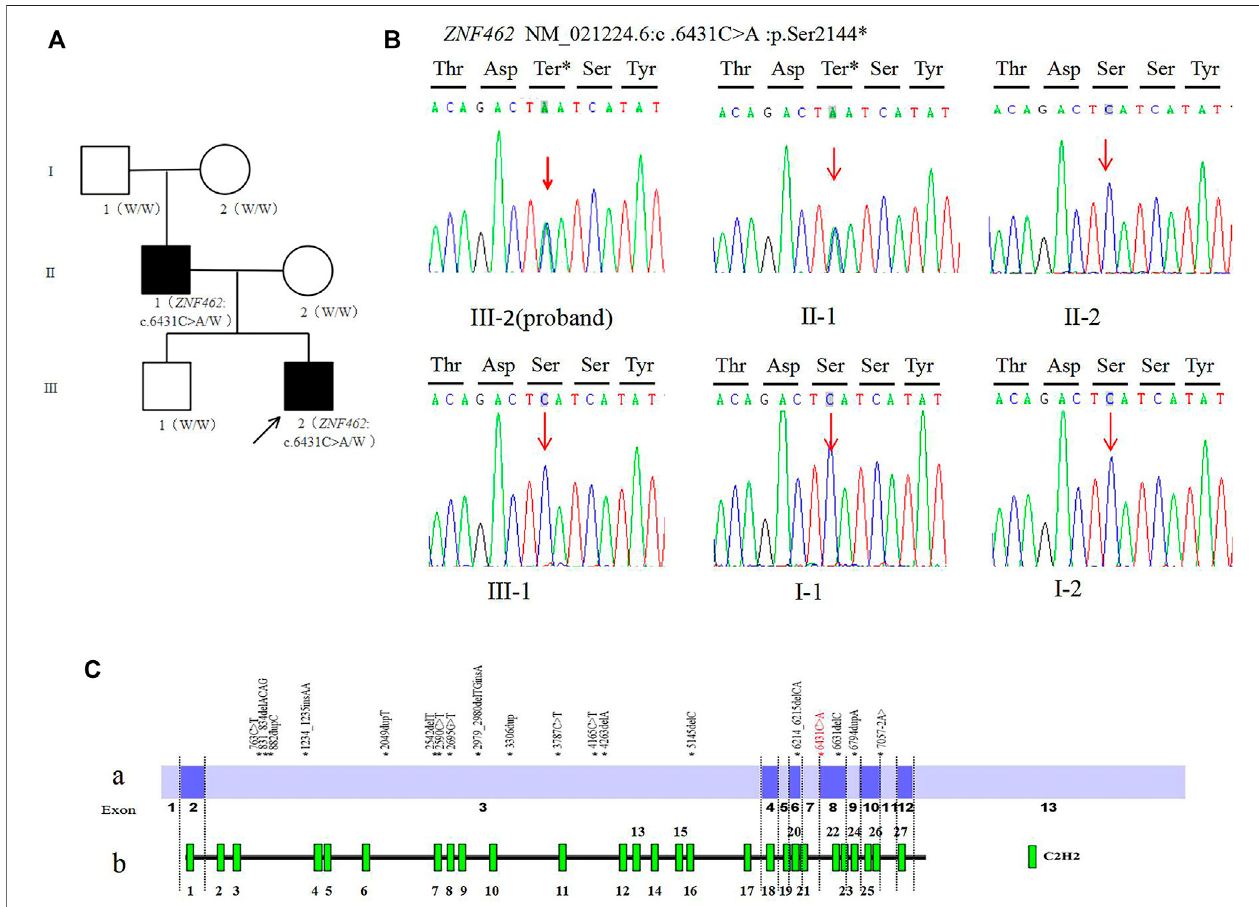
FIGURE 1 | (A) . Family tree of this study (W: Wild type allele); (B) . Sanger sequencing of the ZNF462: c.6431C > A variant of family (C) . Distribution diagram of ZNF462 gene variation (red fonts is the variant reported in this study) Ca. Distribution diagram of ZNF462 gene variants reported in the HGMD database (numbers represent exons) Cb. Schematic diagram of C2H2 zinc fi nger structure distribution of ZNF462